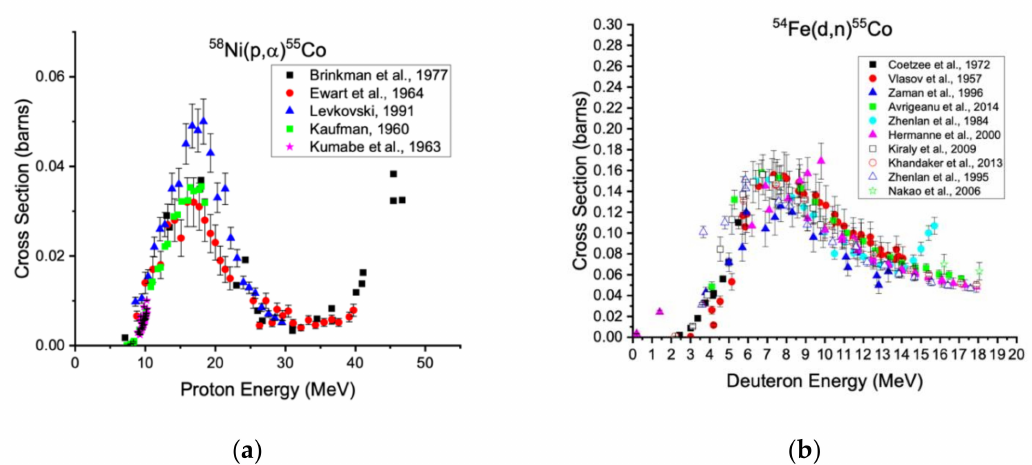
Figure 1. Cross section data for the production of cobalt-55 via the 58 Ni(p, α ) 55 Co ( a ) and 54 Fe(d,n) 55 Co reactions ( b )